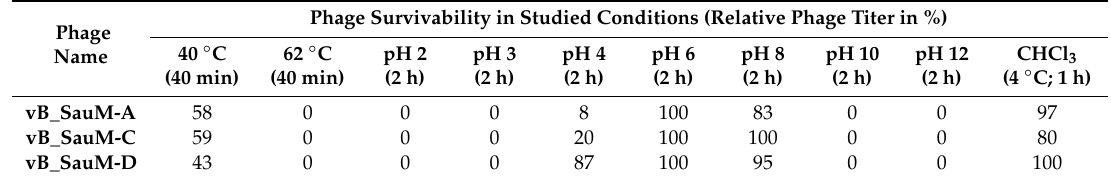
Table 4. Bacteriophages sensitivity to physical and chemical factors.